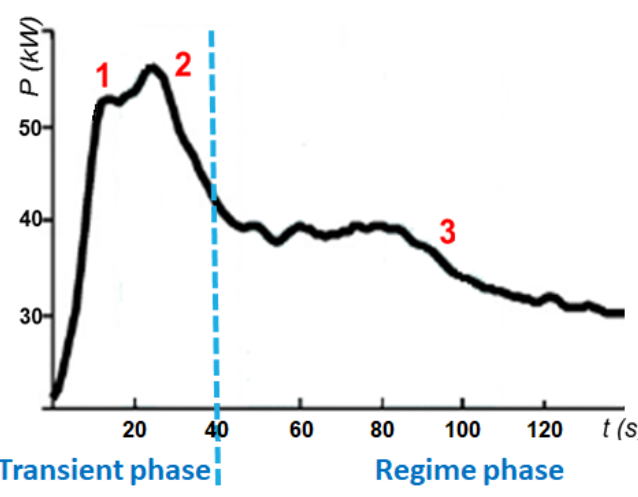
Figure 1. Power absorption curve for a generic mixing cycle.